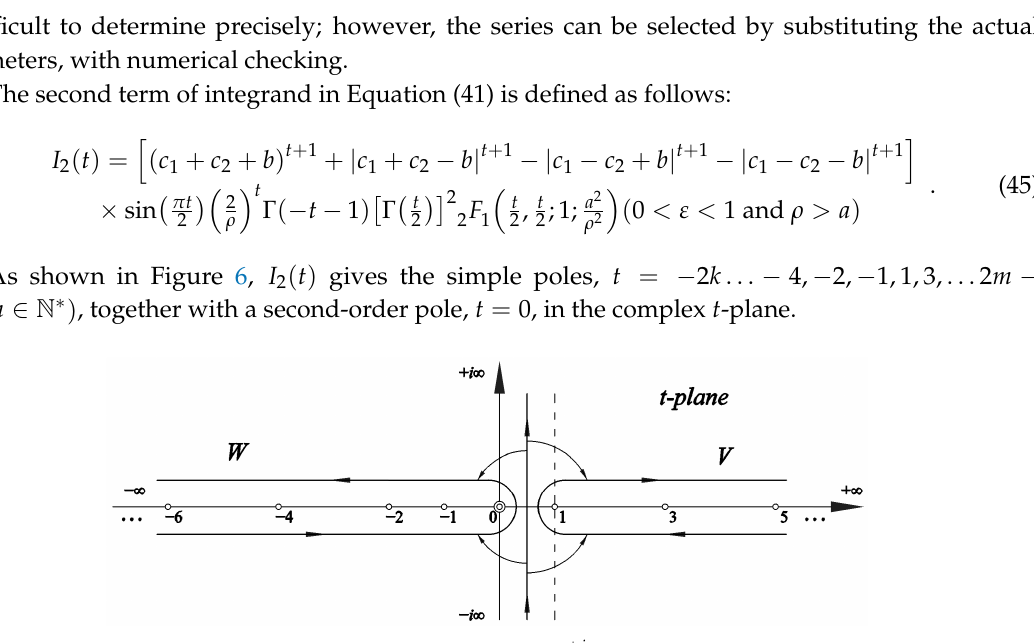
Figure 6. Deformations of the integration path of µ 0 and the poles on the real axis. Similarly, the integration path of µ 0 (rightward), as shown in Figure 6. The residue theorem gives the series under different paths,